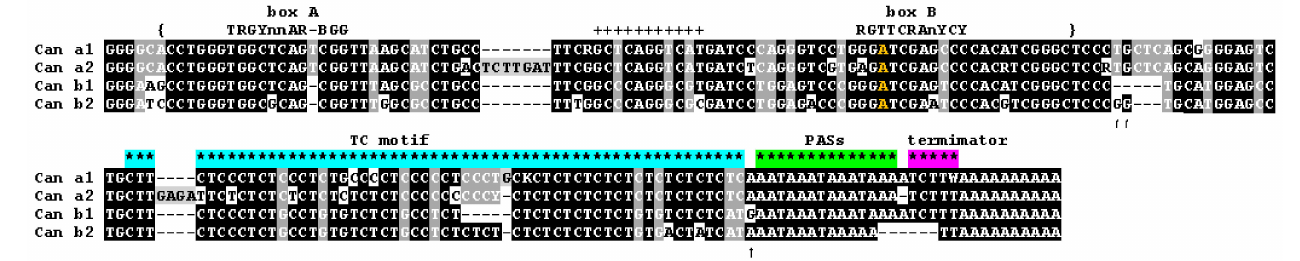
Figure 2. Consensus nucleotide sequences of four Can SINE subfamilies in canids. Consensus sequences of box A and box B of pol III promoter are shown above the alignment. The A nucleotide in the box B differing from the canonical consensus is given in orange. The TC-motif, polyadenylation signals (PASs), and pol III transcription terminator are indicated by asterisks of different colors. The boundaries of the tRNA-related sequence are marked by curly brackets. Plus signs indicate the insertion relative to lysine tRNA. Arrows indicate the distinctive characters of b1 and b2